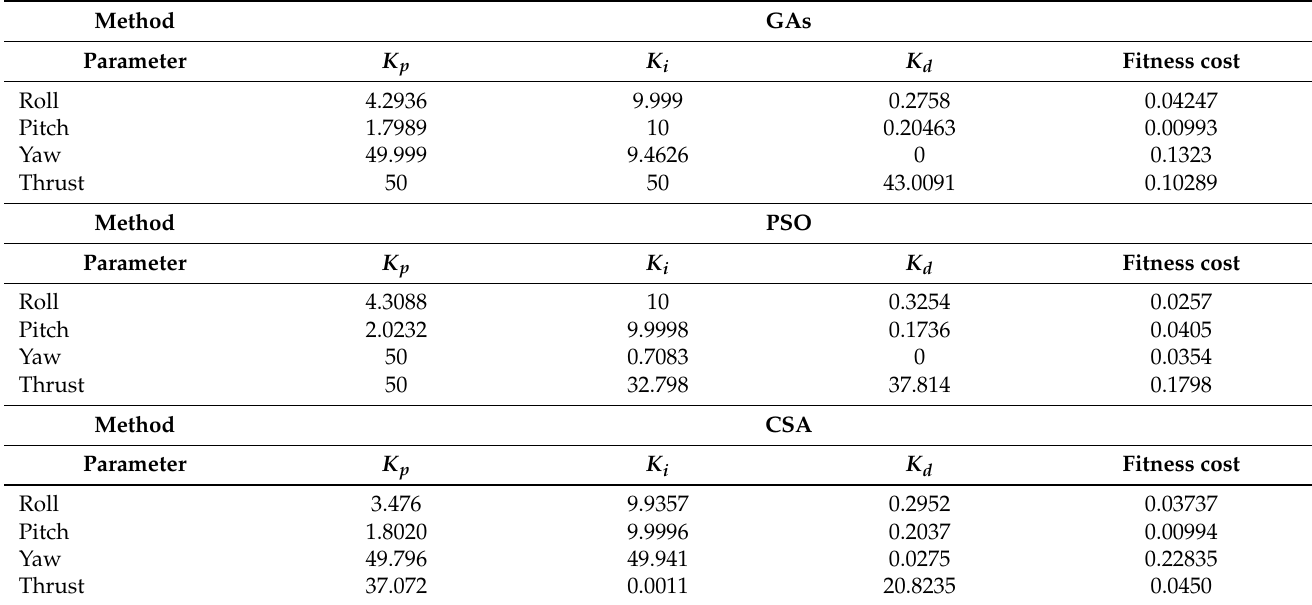
Table 3. The fitness and PID controller values for the quadcopter inputs as obtained by GAs, PSO and